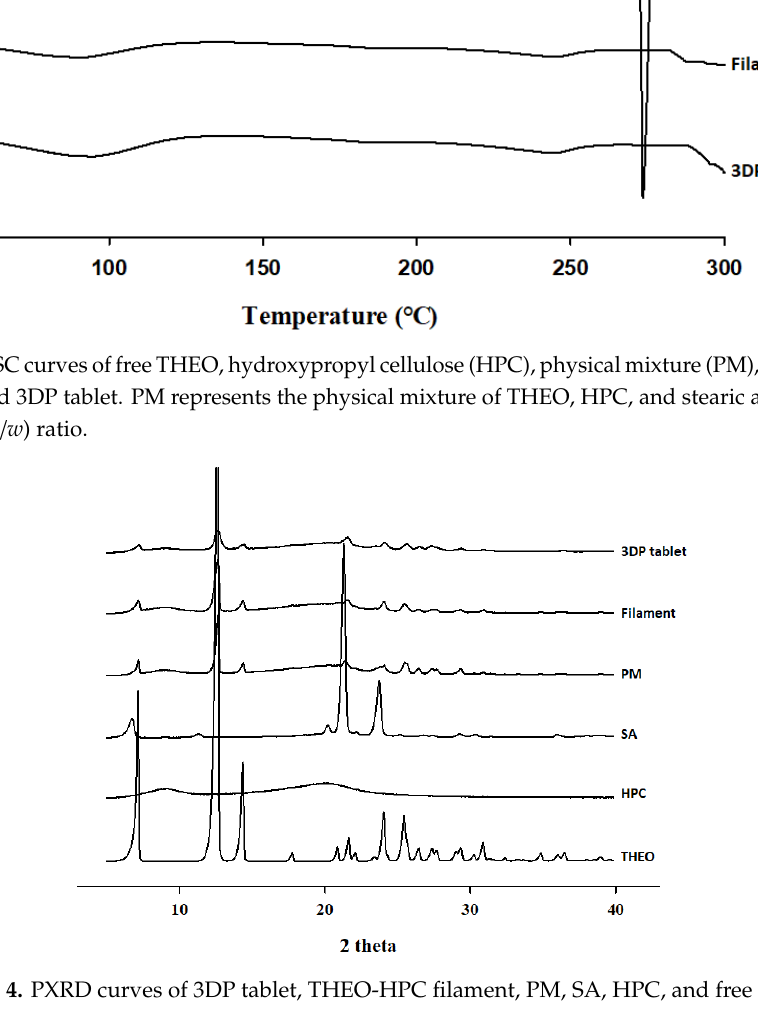
Figure 3. DSC curves of free THEO, hydroxypropyl cellulose (HPC), physical mixture (PM), THEO- HPC filament, and 3DP tablet. PM represents the physical mixture of THEO, HPC, and stearic acid (SA) at a 30:70:7 ( w / w / w ) ratio.